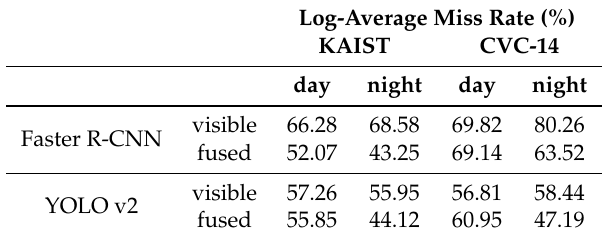
Table 2. Cross-detector and cross-dataset performance